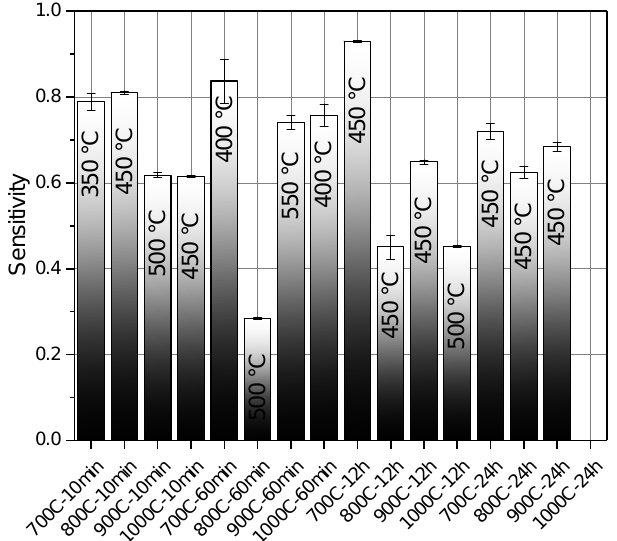
Figure 8. Maximum sensitivity S with error. Within the bars, the temperature at which the maximum was reached is given.